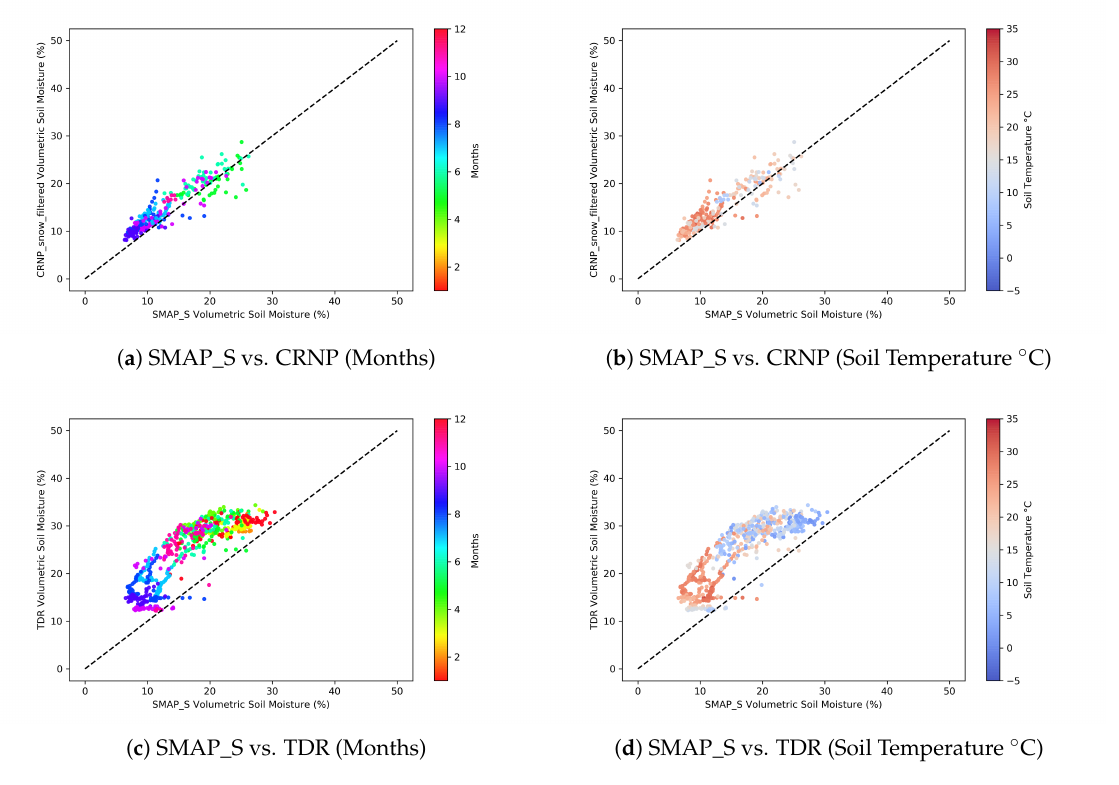
Figure A5. Comparisons between SMAP_S Soil Moisture Product with CRNP and TDR.